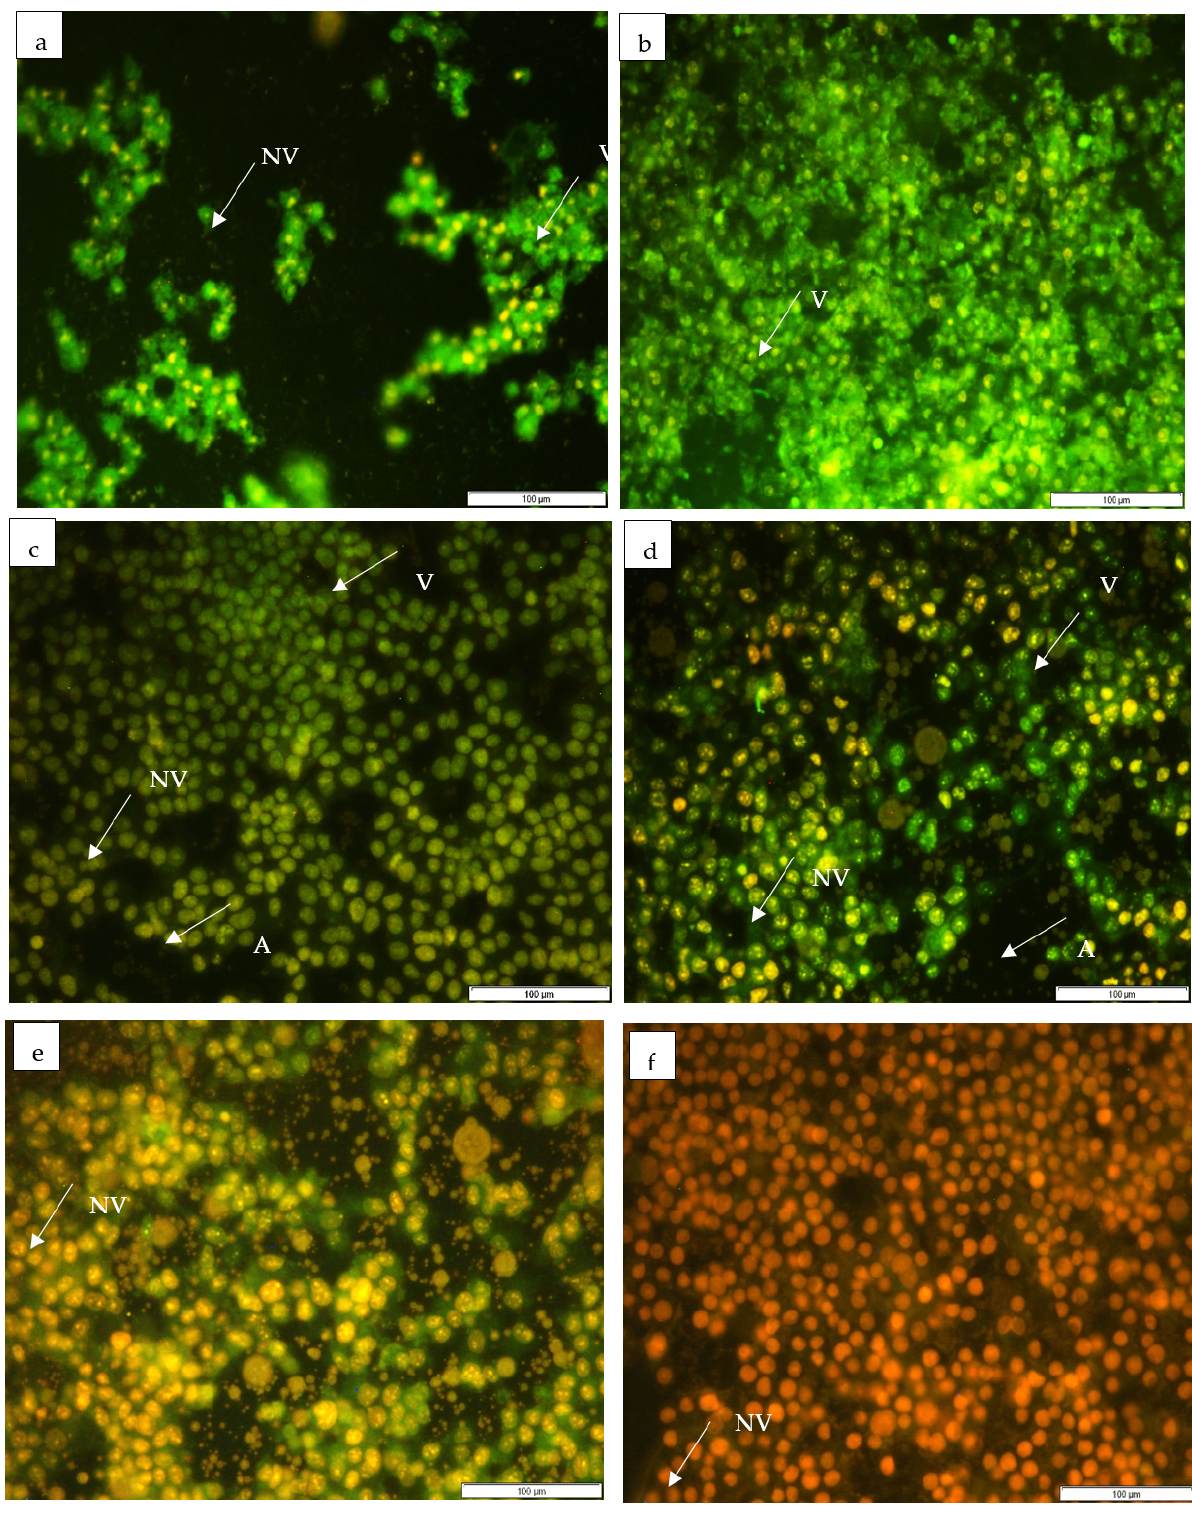
Figure 6. Light micrographs indicating the cell viability of MCF-7 cells stained using acridine orange and exposed to the following extracts: ( a ) leaf and ( b ) stembark hexane extract, ( c ) leaf and ( d ) stembark chloroform extract, and ( e ) leaf and ( f ) stembark methanolic extracts of C. erythrophyllum (A—apoptotic cell; V—viable cell; NV—non-viable cell).